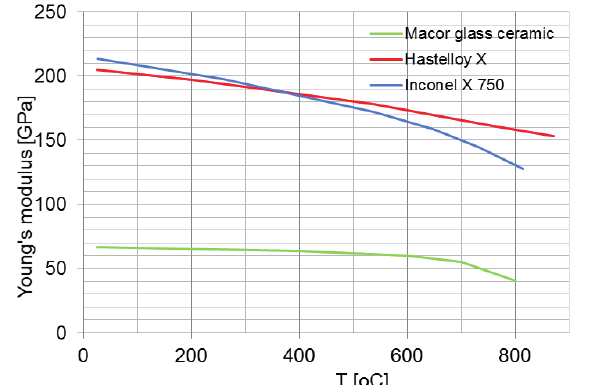
Figure 4: Young’s modulus as a function of temperature for selected elements of the mSOFC stack [27-29].